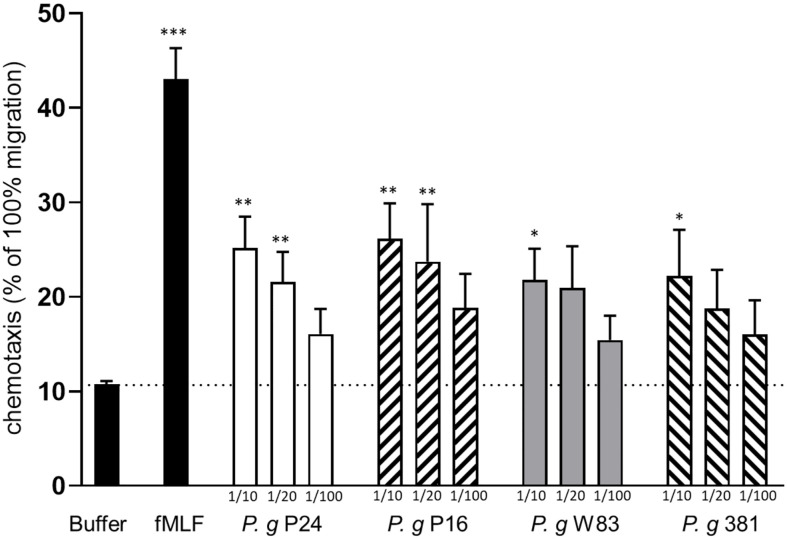
Culture supernatants of P. gingivalis induce chemotaxis of human neutrophils. Neutrophils isolated from peripheral blood of healthy humans were allowed to migrate over a ChemoTx membrane towards chemotactic stimuli (bacterial supernatants (1:10, 1:20, 1:100), fMLF (10 nM)) or buffer) for 90 min. Migrated cells were quantified by measurement of myeloperoxidase activity after cell lysis. Six independent experiments were performed and each stimulus was analyzed in triplicates (technical repeats). Values shown are calculated as percentage of positive control (100% migration of cells) and are presented as mean values with SEM. Friedman test followed by Dunn´s multiple comparison test was used for statistical analysis. *< 0.05, **< 0.01, ***< 0.001.